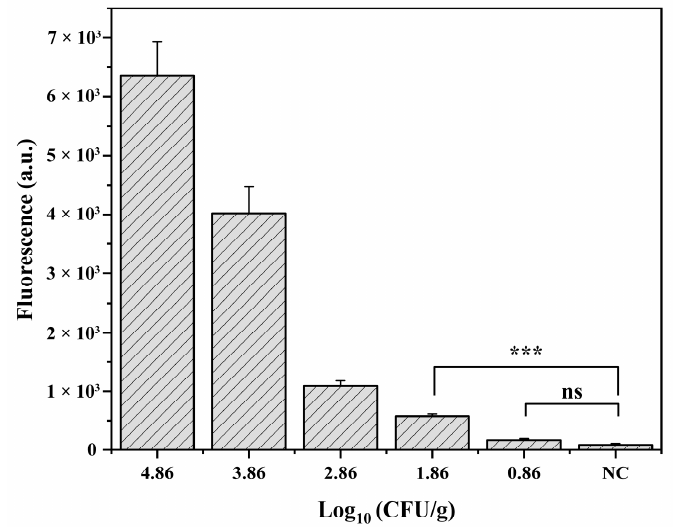
Figure 6. LOD of the CE–RAA–CRISPR for the detection of V. parahaemolyticus in shrimp. *** indicated a statistically significant difference, p < 0.001; ns indicates no significant difference.